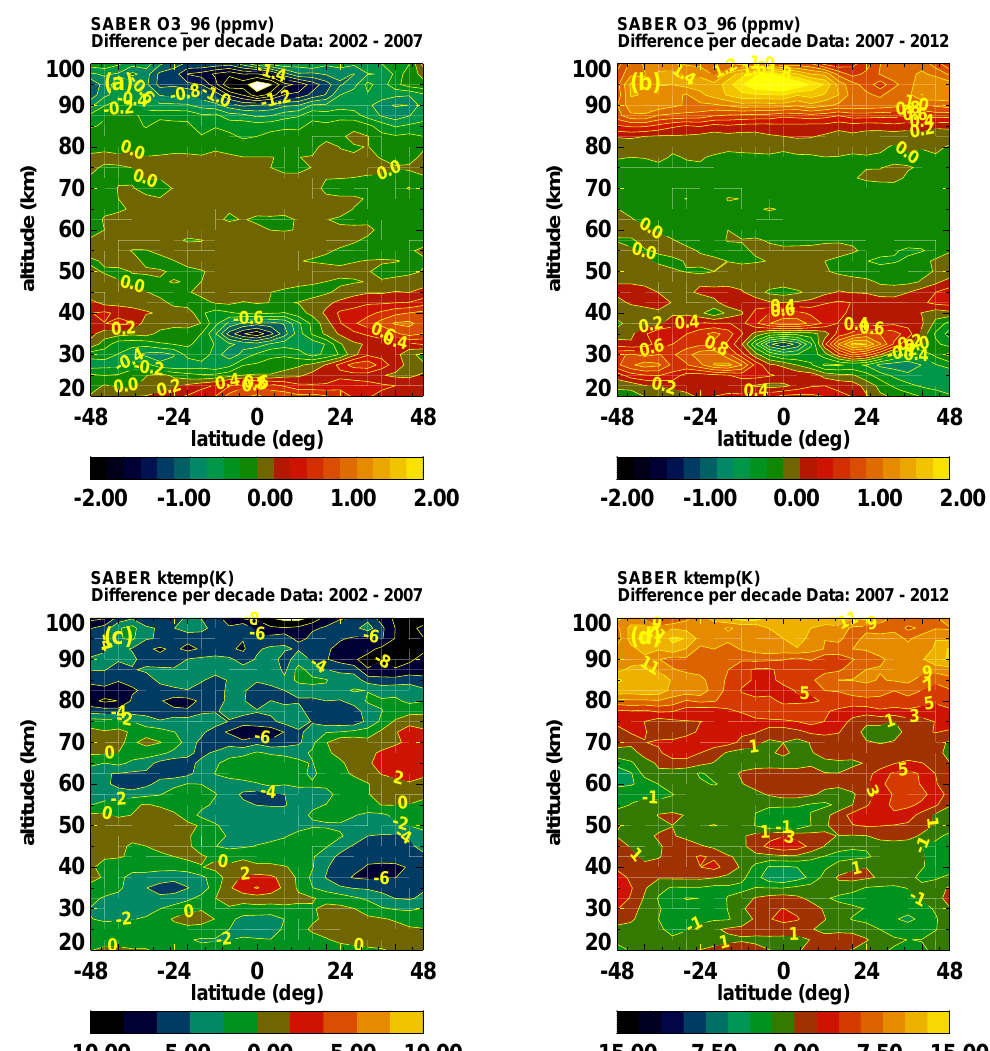
Figure 3. Ozone and temperature trends on altitude (20 to 100km) vs. latitude (48 ◦ S to 48 ◦ N). Top row: ozone trends from 2002 to 2007 (declining solar activity; left); ozone trends from 2007 to 2012 (increasing solar activity; right). Bottom row: as in top row, but for temperature. Brown-green areas denote zero contour borders, with brown and red areas denoting positive